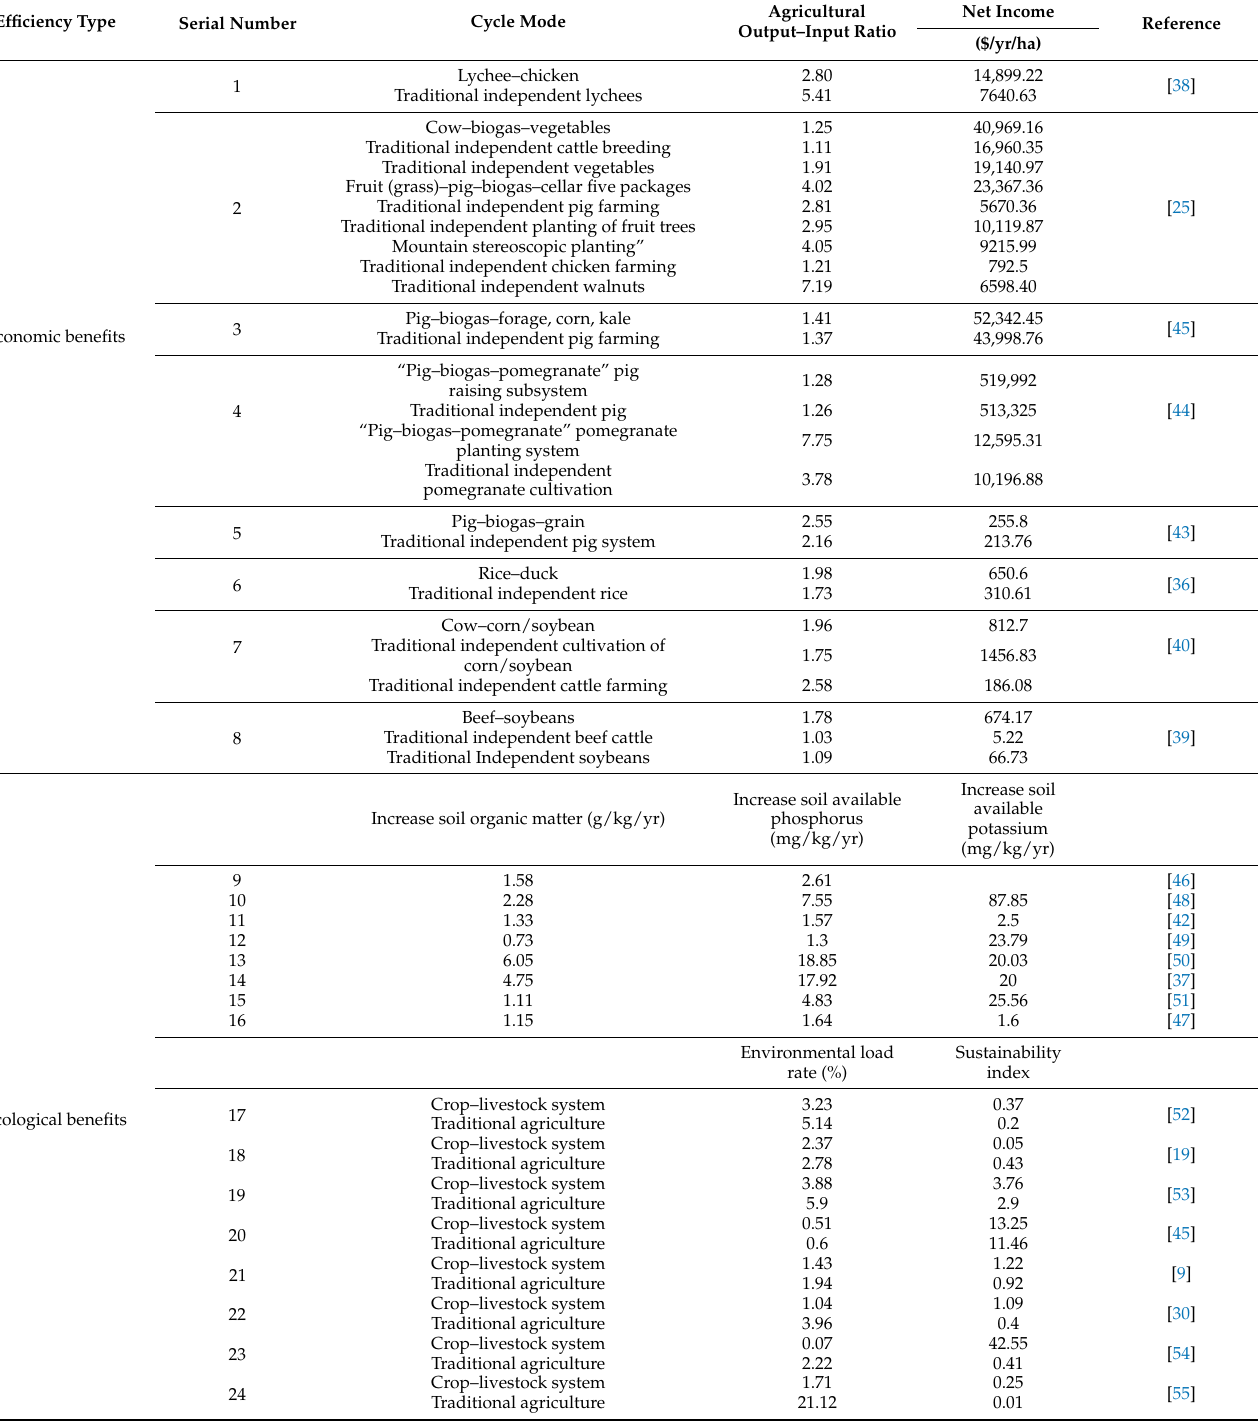
Table 2. Economic and ecological benefits of crop–livestock